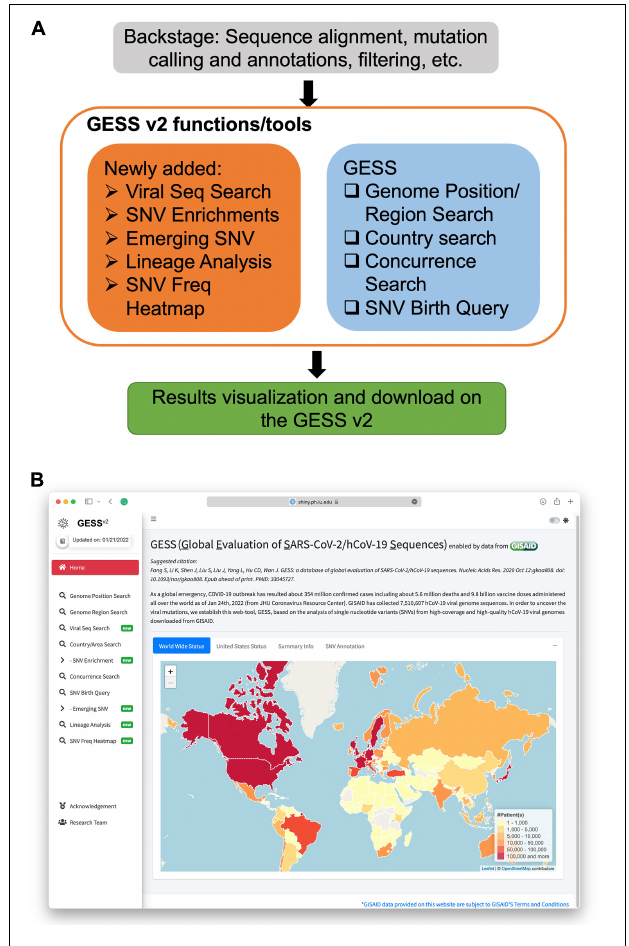
FIGURE 1 | Overview of the global evaluation of SARS-CoV-2/hCoV-19 sequences 2 (GESS v2). (A) The GESS v2 functions/tools including the updated ones and those existing in the first version of the GESS. (B) Landing page of the GESS v2, where new functions are marked with “new” badges.